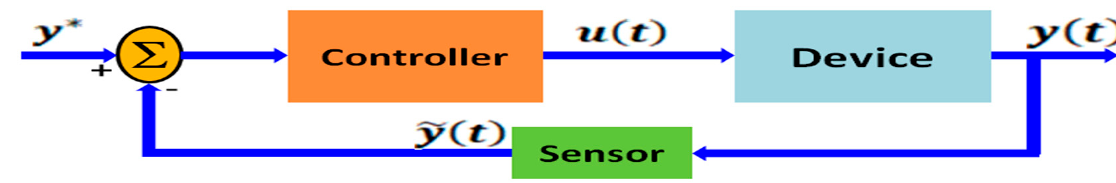
Figure 4. The conceptual structure of a feedback controller. u ( t ) : control signal, y ( t ) : controlled device’s output, y ∗ : desired device’s output, (cid:101) y ( t ) : mearing device’s output.